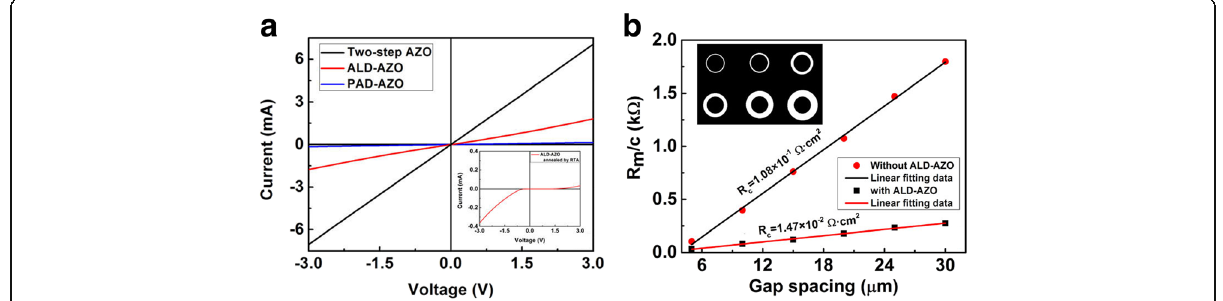
Fig. 3 a Current-voltage characteristics of PAD-AZO, ALD-AZO and two-step AZO grown on p-GaN. The inner graph of ( a ) shows the I-V curve of ALD-AZO that annealed by RTA in N 2 for 60 s. b shows the raw data and linear fitting data of the specific contact of the PAD-AZO (without ALD-AZO) and two-step AZO (with ALD-AZO) to extract specific contact resistance, the inner graph of ( b ) shows the structure of